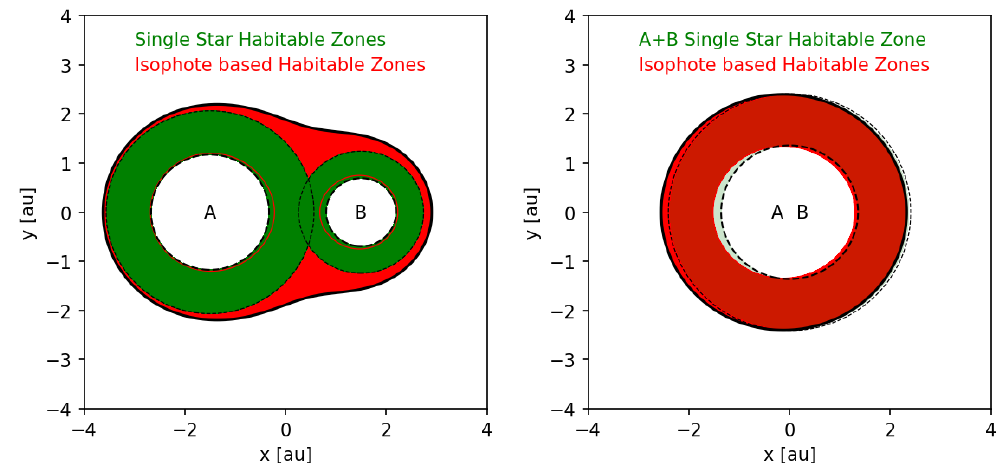
Figure 2. Same as Figure 1 only for systems with semi-major axes of a b = 3 au and a b = 0.5 au,